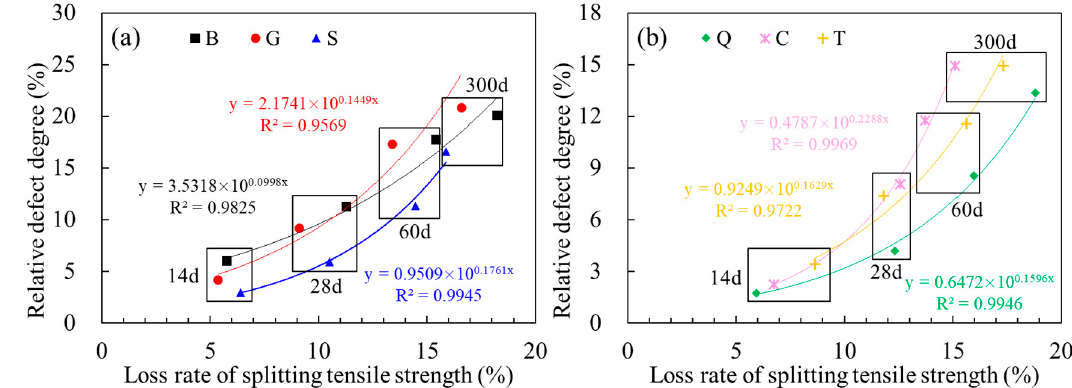
Figure 9. The internal defects of new-to-old concrete: ( a ) Group B, G, and S; ( b ) Group Q, C, and T.